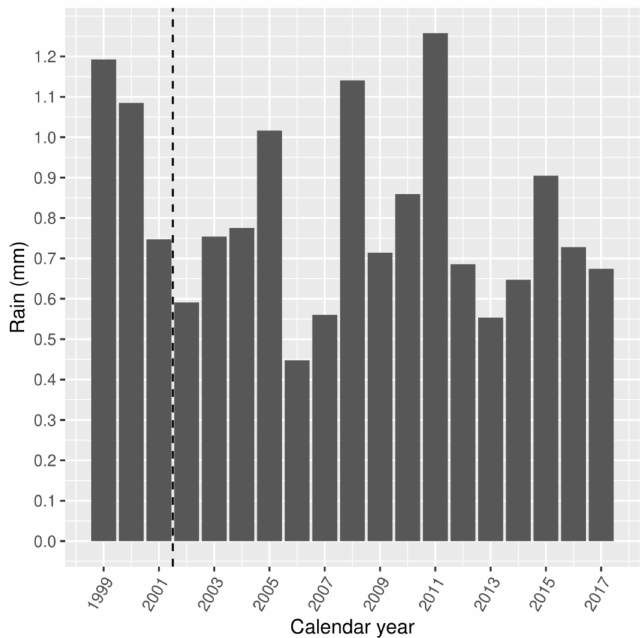
Figure 4. Mean daily rainfall (mm) by calendar year.